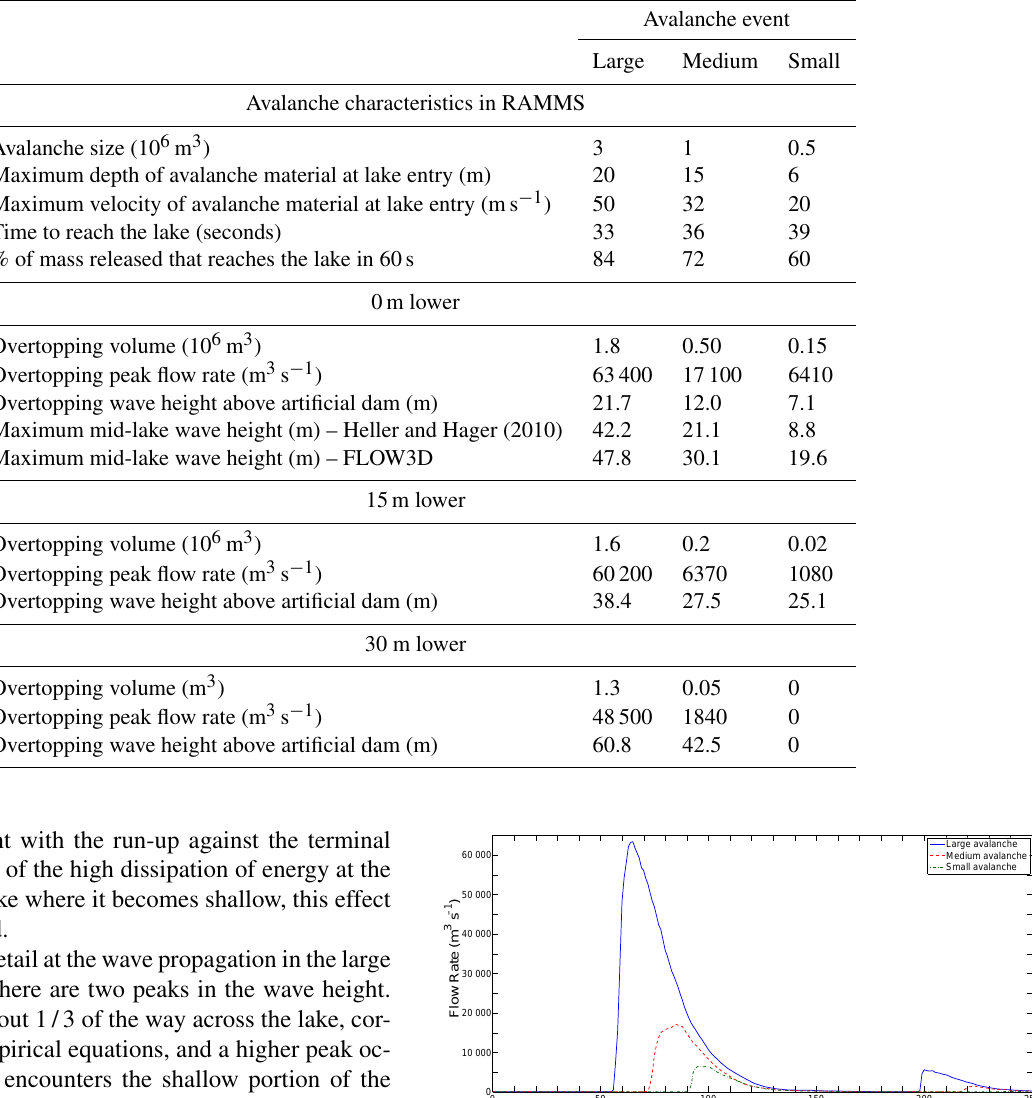
Table 4. Characteristics of three avalanche events of different sizes as simulated in RAMMS. Overtopping volume, flow rate and wave height for three avalanche events as simulated in FLOW3D for the current lake level and three lake mitigation scenarios. Comparison of mid-lake wave heights between Heller and Hager (2010) equations and FLOW3D simulations for a 0m lower scenario.